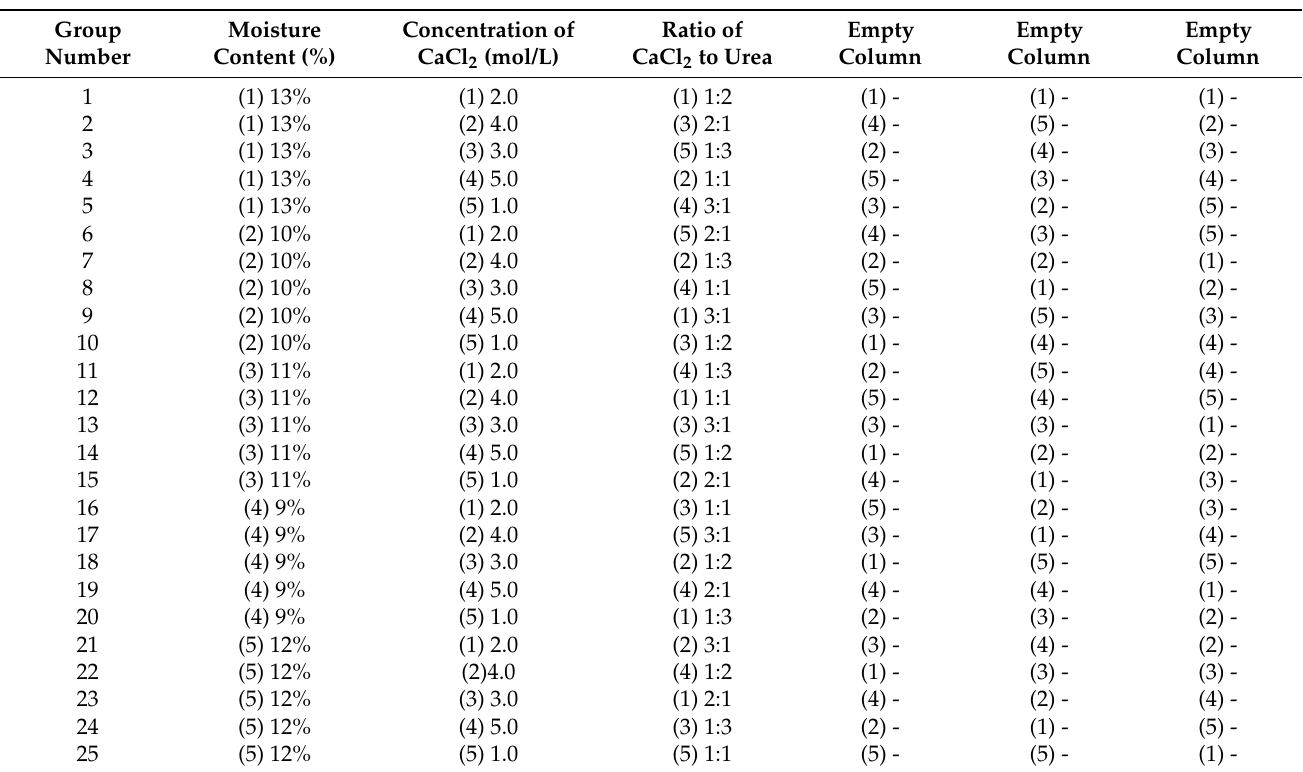
Table 2. The orthogonal experiment